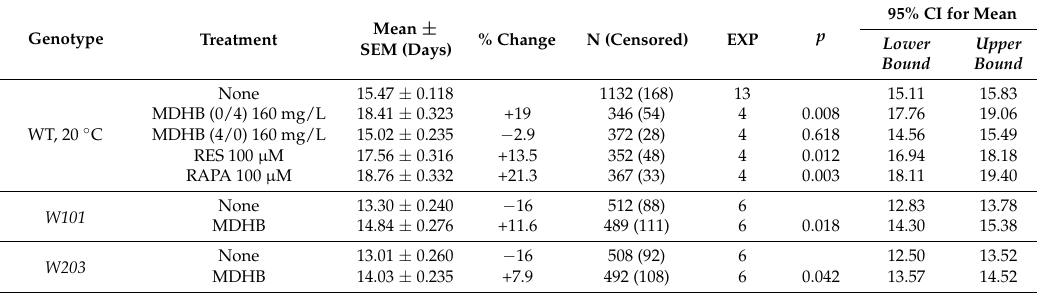
Table 1. Summary of mean life-spans of C. elegans